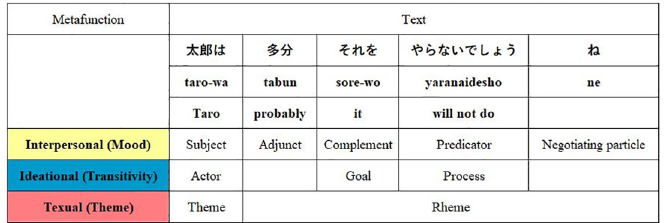
Fig 5. The relation between metafunctions and a text. Text denotes every interaction, whether spoken or written, unfolding in some context of use [34].